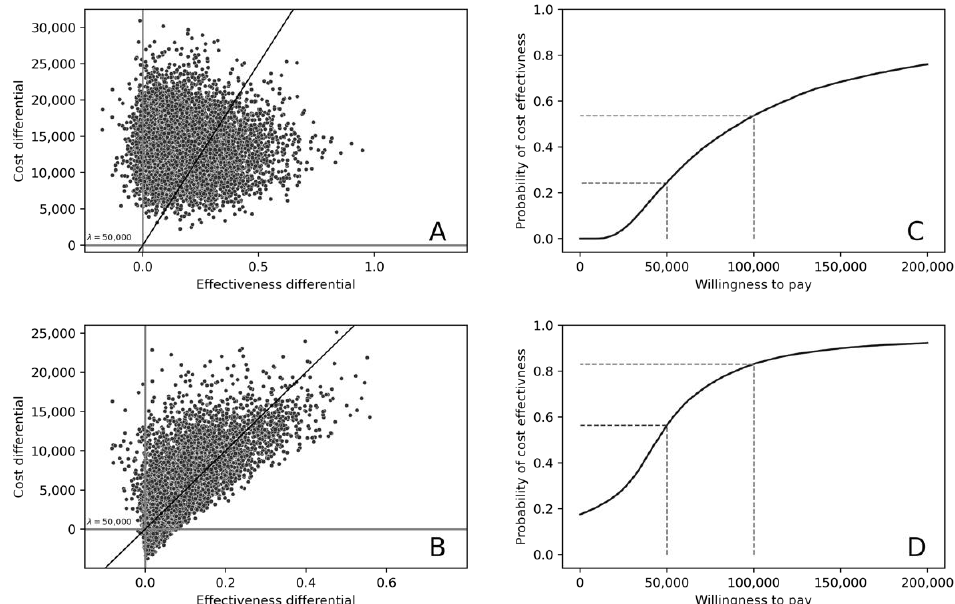
Figure 3. Cost-Effectiveness Acceptability Planes for ( A ) first- and ( B ) second line GEP-informed treatment of ABC subtype DLBCL, and Cost-effectiveness Acceptability Curves for ( C ) first- and ( D ) second line GEP-informed treatment of ABC subtype DLBCL. Figure 3 legend: ( A , B ) depict scatter plots of incremental cost-effectiveness ratios (ICERs) generated from the probabilistic analysis ( n = 10,000 iterations). The upper right (North-West) quadrant of the cost effectiveness planes are shown, with ICERs demonstrating higher incremental costs alongside higher incremental effectiveness. In the first line treatment setting, 96% of simulated ICERs indicate higher incremental cost and higher incremental effectiveness ( A ), with 24% below a $50,000/QALY threshold ( λ ) which is the willingness-to-pay for an effectiveness gain. In the second line setting, respective proportions are 81% and 39%. Cost-effectiveness acceptability curves ( C , D ) illustrate the probability that GEP guided treatment is cost-effective at different levels of willingness-to-pay per additional QALY. The probabil- ity that first-line GEP-informed treatment was cost-effective at $50,000/QALY and $100,000/QALY were 24.3% and 53.7% respectively, and 56.3% and 83.1%, respectively, in second line